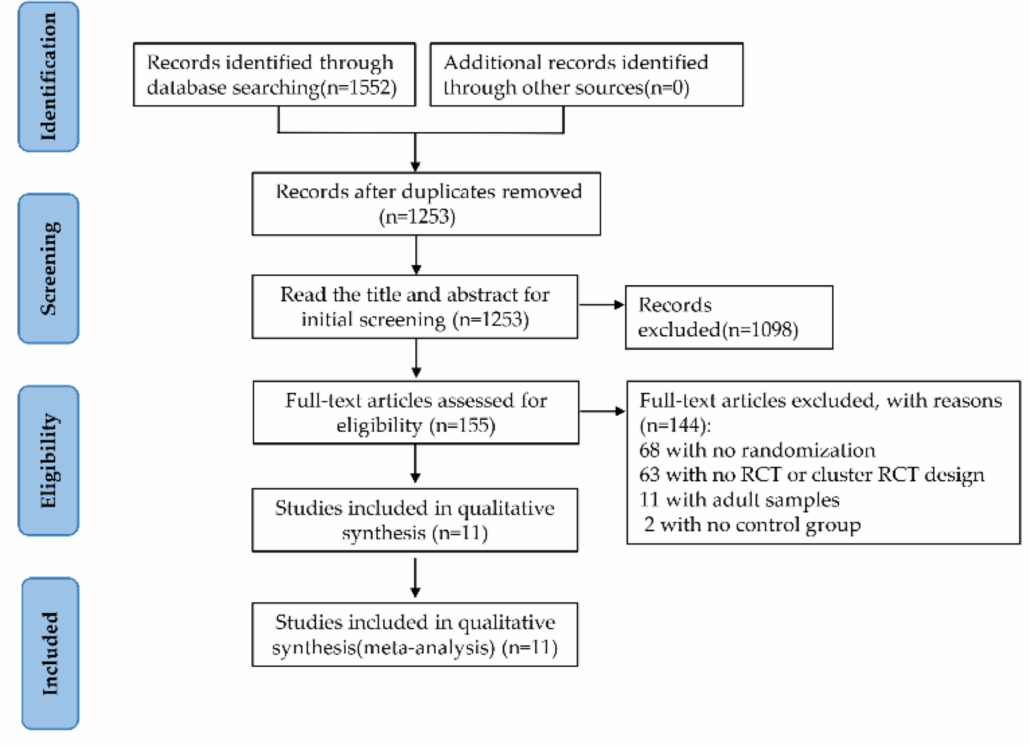
Figure 1. Flowchart of Literature Search and Study